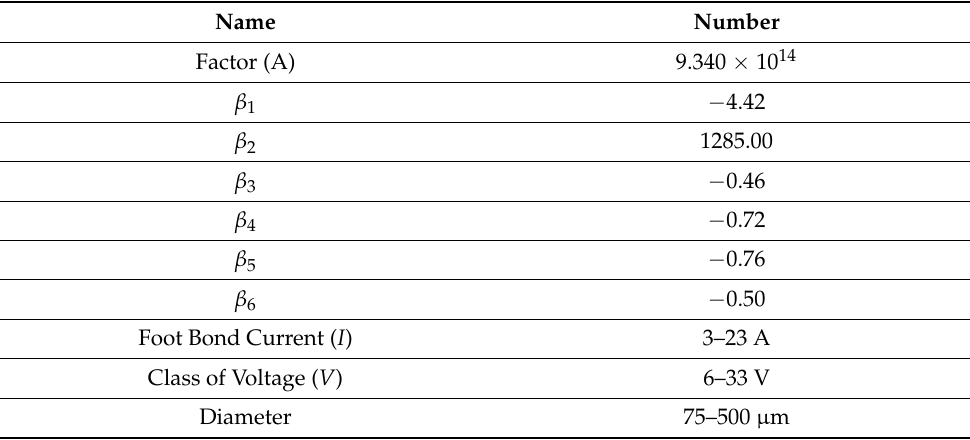
Table 1. Parameters of the lifetime